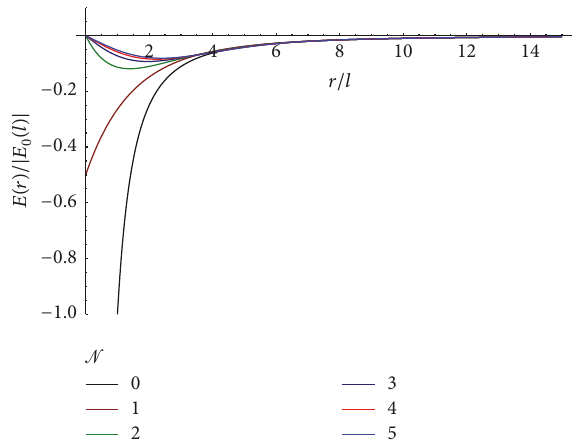
Figure 5: The gravitational force for different values of N . We have defined 𝐹 0 (𝑙) = −𝐺𝑀 1 𝑀 2 /𝑙 2